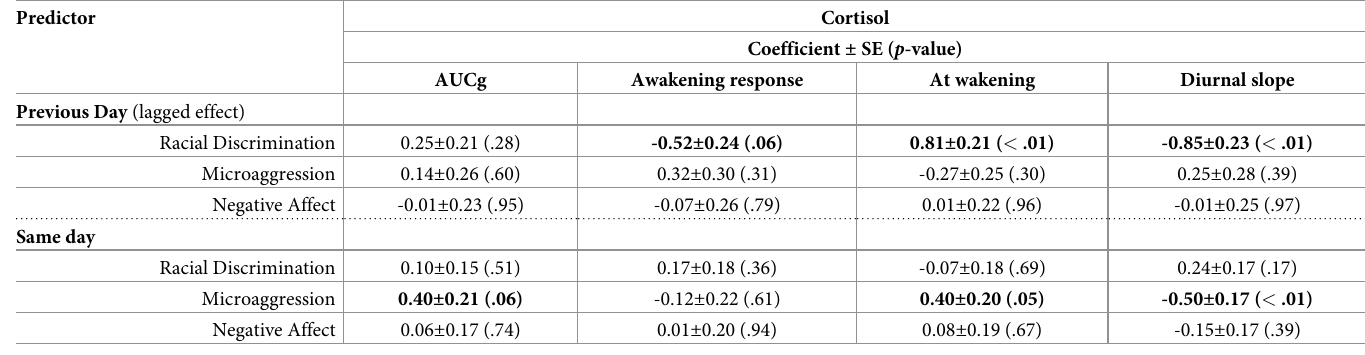
Note. Area Under the Curve ground (AUCg).